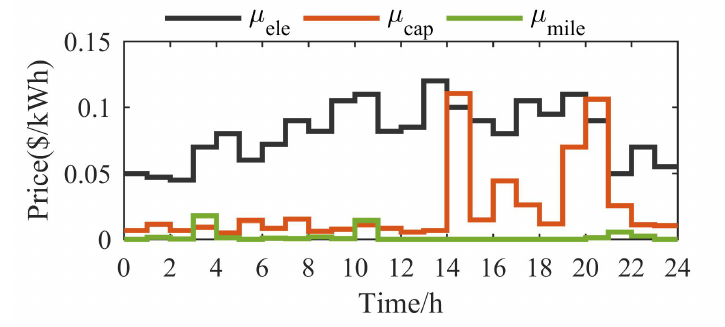
Figure 7. Prices used in the